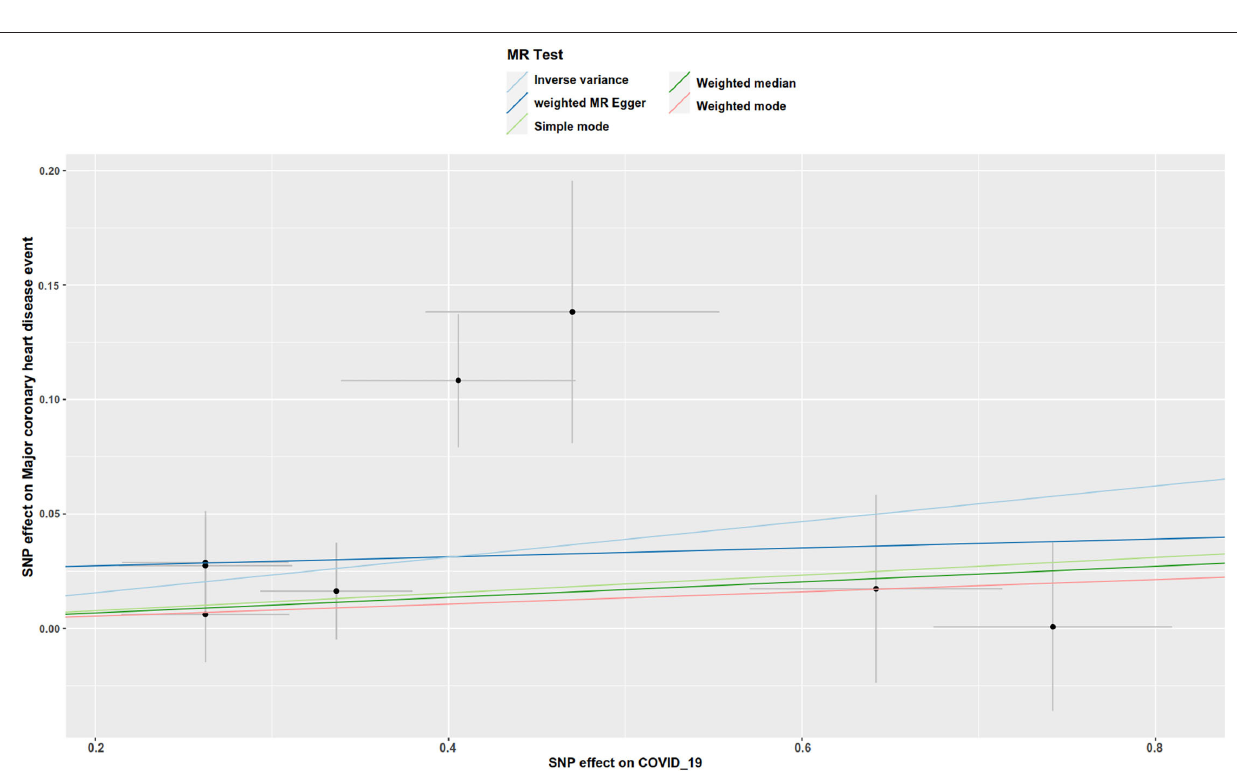
FIGURE 3 | Scatter plot to visualize the causal effect of COVID-19 on the risk of major coronary heart disease events. The slope of the straight line indicates the magnitude of the causal association. IVW, inverse-variance